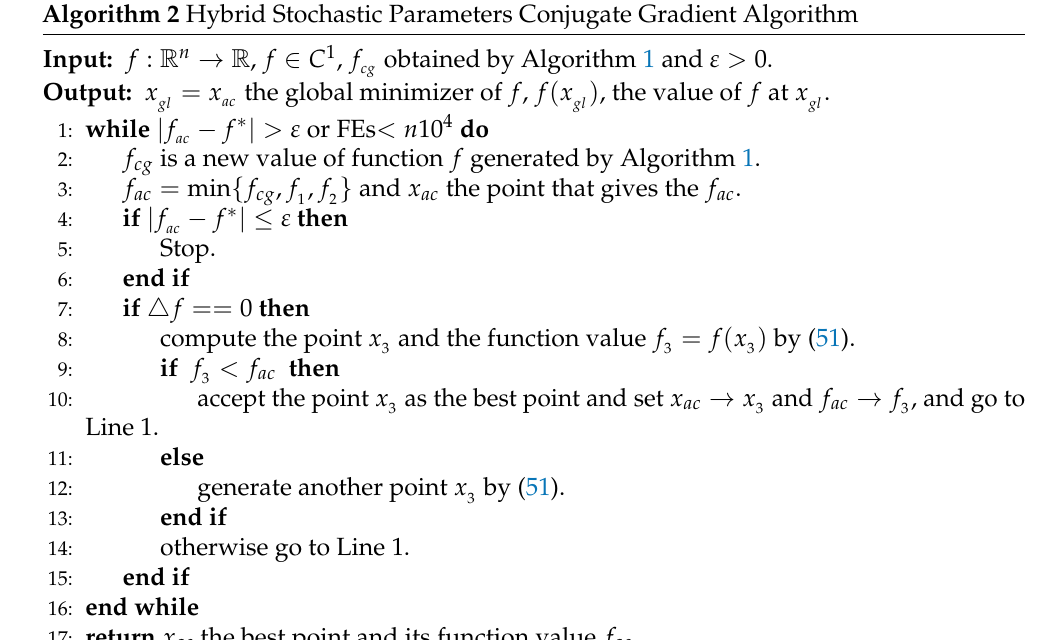
Stochastic Parameters Algorithm